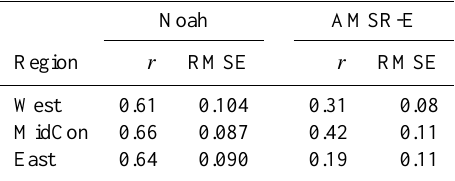
Table 3. Temporal correlations ( r ) and root mean square errors (RMSE) of Noah/AMSR-E soil moisture with respect to SCAN measurements. Statistics were first calculated at each SCAN site and then averaged over all SCAN locations in each